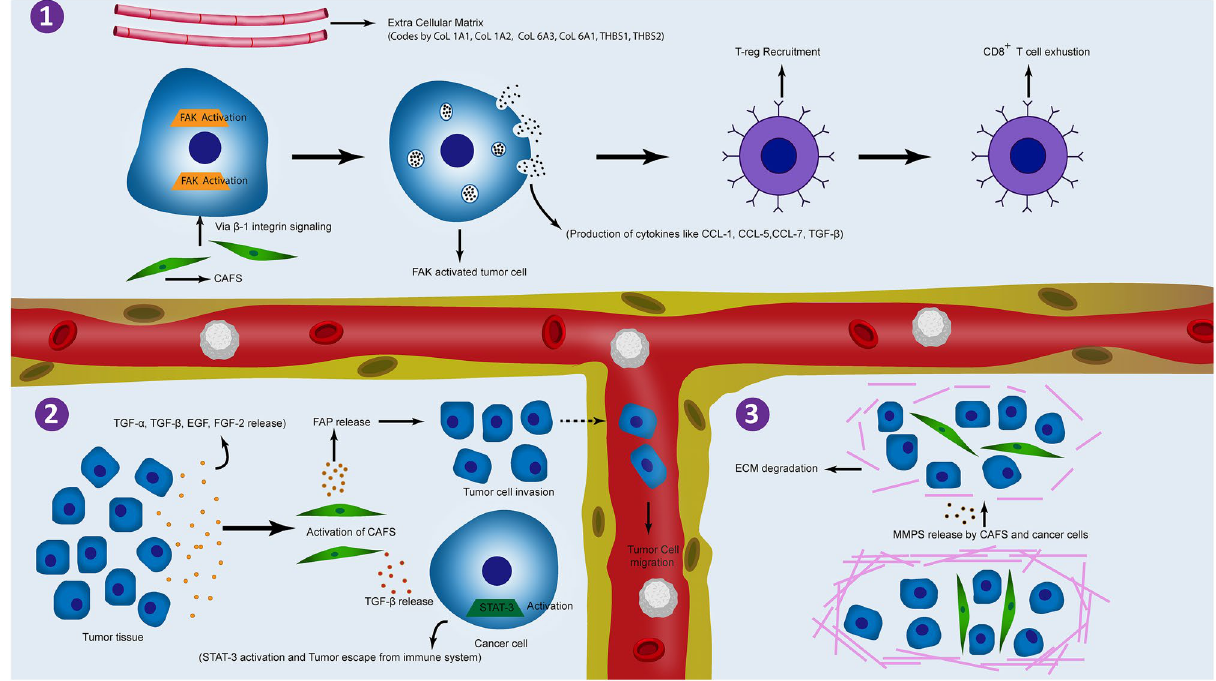
Figure 6. Focal adhesion signaling. ( 1 ) ECM and CAFs activating focal FAK in cancer cells leading to cytokine production. These cytokines can finally inhibit CD 8+ T-cell activation. ( 2 ) Tumor cells release different cytokines resulting in CAF activation. This can finally cause tumor metastasis and escaping from immune cells induced by activated CAFs. ( 3 ) Activated CAFs and tumor cells can release MMPs leading to ECM degradation, which promotes tumor metastasis. *ECM: extracellular matrix; CAFs: cancer associated fibroblasts; FAK: focal adhesion